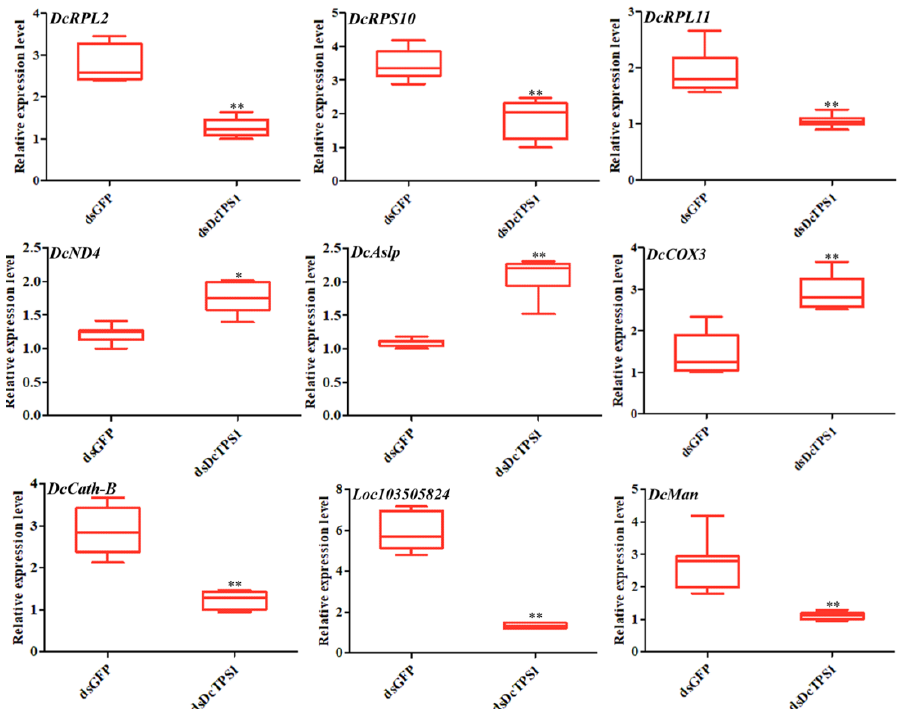
Figure 11. Validation of DEGs involved with the ribosome, oxidative phosphorylation and lysosome, respectively. The mean expression level represents three biological replicates. The asterisks indicate the significance differences by * p < 0.05 and ** p < 0.01. The SPSS software was used to conduct statistical analysis.